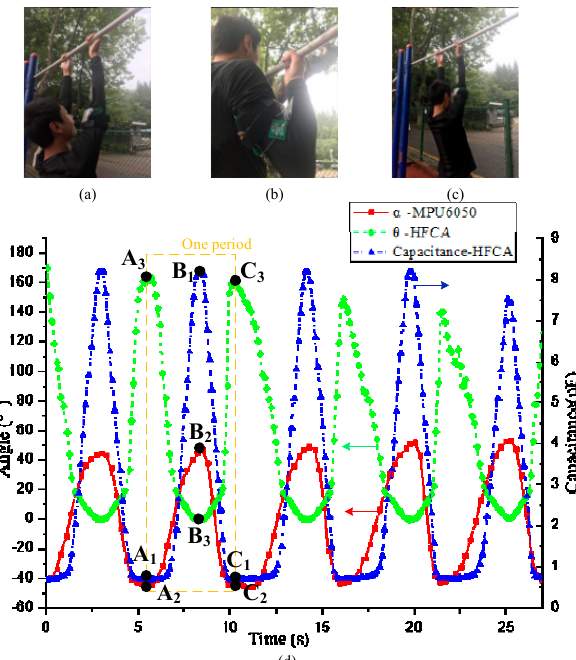
Figure 8. Pull-ups experimental results. ( a ) Preparation; ( b ) Pulling status; ( c ) Hanging down; ( d ) Experimental results.